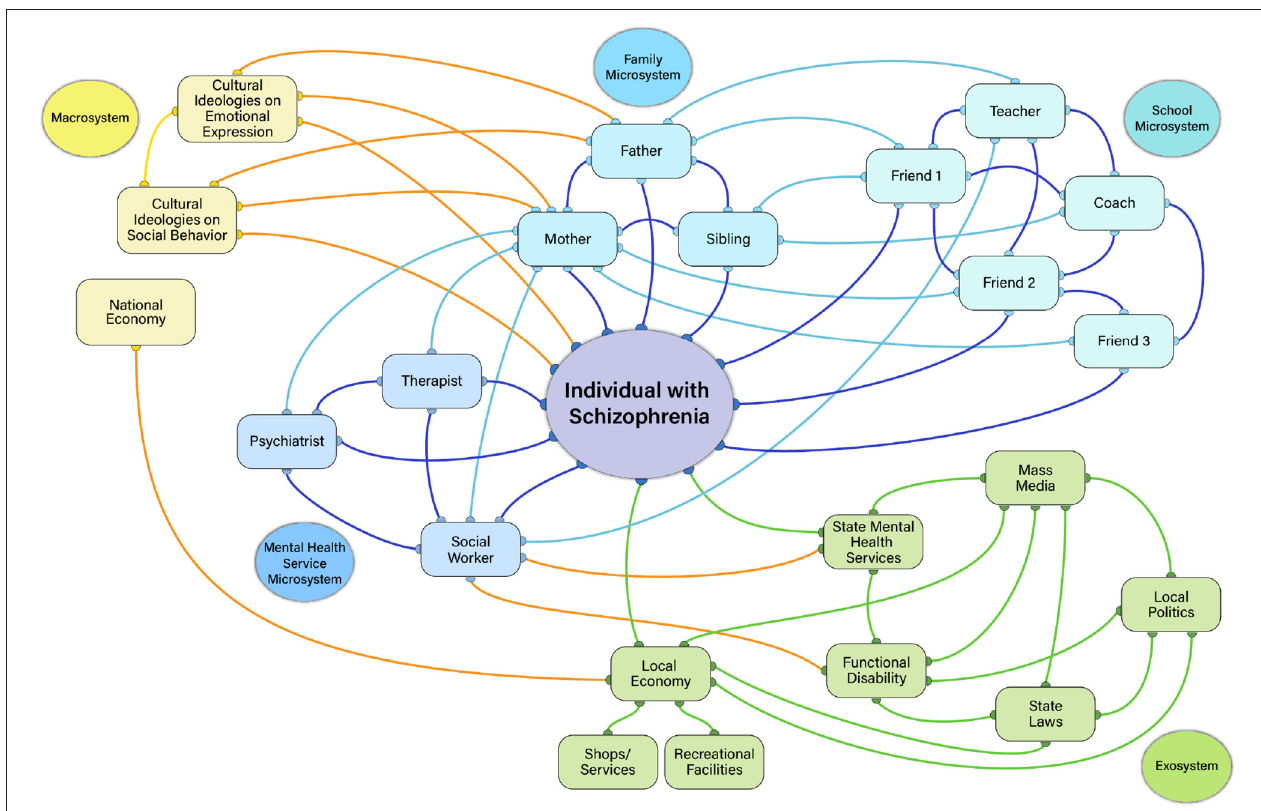
FIGURE 2 | Low negative symptom ecosystem network illustration. In this example, imagine an 18 years old male who is in the first episode of schizophrenia with low negative symptoms. He has three prominent microsystem settings: home, school, mental health services. In the home setting, he has strong social ties with his mother, father, and brother, whom are all highly connected to each other. The mother is a highly central driving force in the individual’s microsystem, connecting them (mesosystem) with their mental health services (taking them to appointments with psychiatrist, therapist, social worker, and being part of the treatment) and school (interacting with teachers, coaches, and their friends). The density of connections within and across microsystems, as well as the mother’s high centrality within the network is protective against developing negative symptoms. The family is also deeply connected with their culture (macrosystem): the mother, father, and individual with the illness have all adopted beliefs of their ethnic culture regarding emotional expression, socialization, work/motivation, and pleasurable activities. Strong cultural identification and connection with others of the same culture in the neighborhood and school are protective against negative symptoms. At the level of the exosystem, the individual lives in an affluent suburban area that is rich in resources for social, pleasurable, and goal-directed activities (e.g., recreational centers, shops) that are accessible (they have a car, can walk to facilities, there is low crime). Exosystem factors are not prominently acting on the person. They do not receive functional disability benefits from the state, although these are available. Local politics and state laws are less influential on this person because they are not receiving disability services. Yellow, Macrosystem; Green, Exosystem; Light Blue, Microsystem; Dark Blue, Mesosystem; Orange, cross-system interactions; Purple, Person-Level